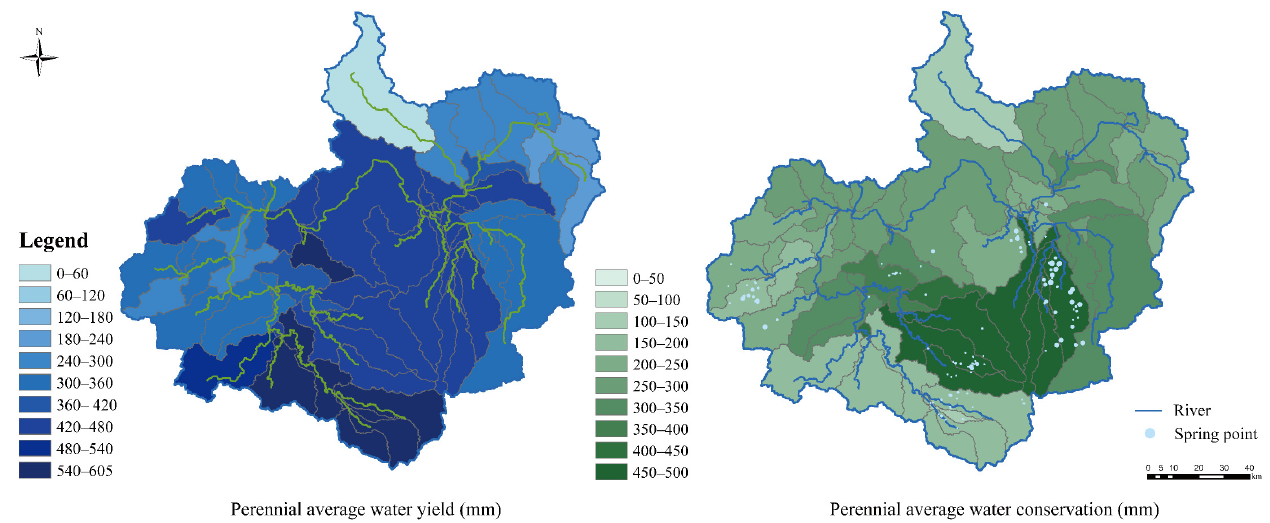
Figure 4. Spatial pattern of annual average water yield amount and water retention amount.